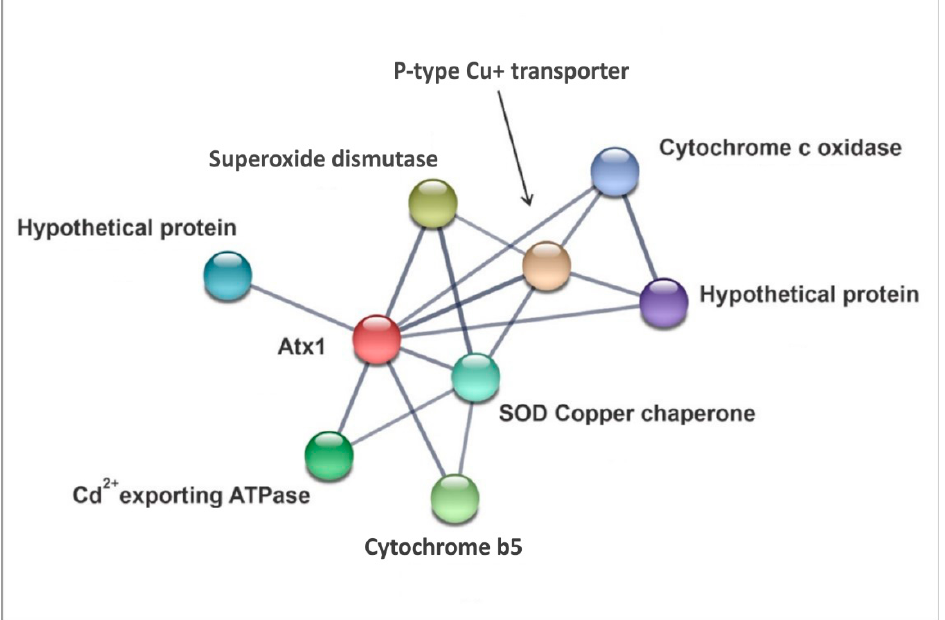
Figure 1. Reactivity of anti- Pb Cyb5 polyclonal antibodies with proteins eluted from the pull-down assay . ( A )—Pull-down eluted proteins were submitted to SDS-PAGE, transferred to a nitrocellulose membrane, and incubated with anti- Pb Cyb5 polyclonal antibodies (dilution 1:250). This positive reaction with anti- Pb Cyb5 in pull-down elution corroborates with our mass spectrometry data indicating Pb Cyb5 as a Pb Atx1 partner protein. ( B )—As a positive control to test the reactivity of the antibody, cytoplasmatic protein extracts obtained from P. brasiliensis were also incubated with anti- Pb Cyb5 (dilution 1:250). ( C )—Negative control using pre-immune serum (1:1000).